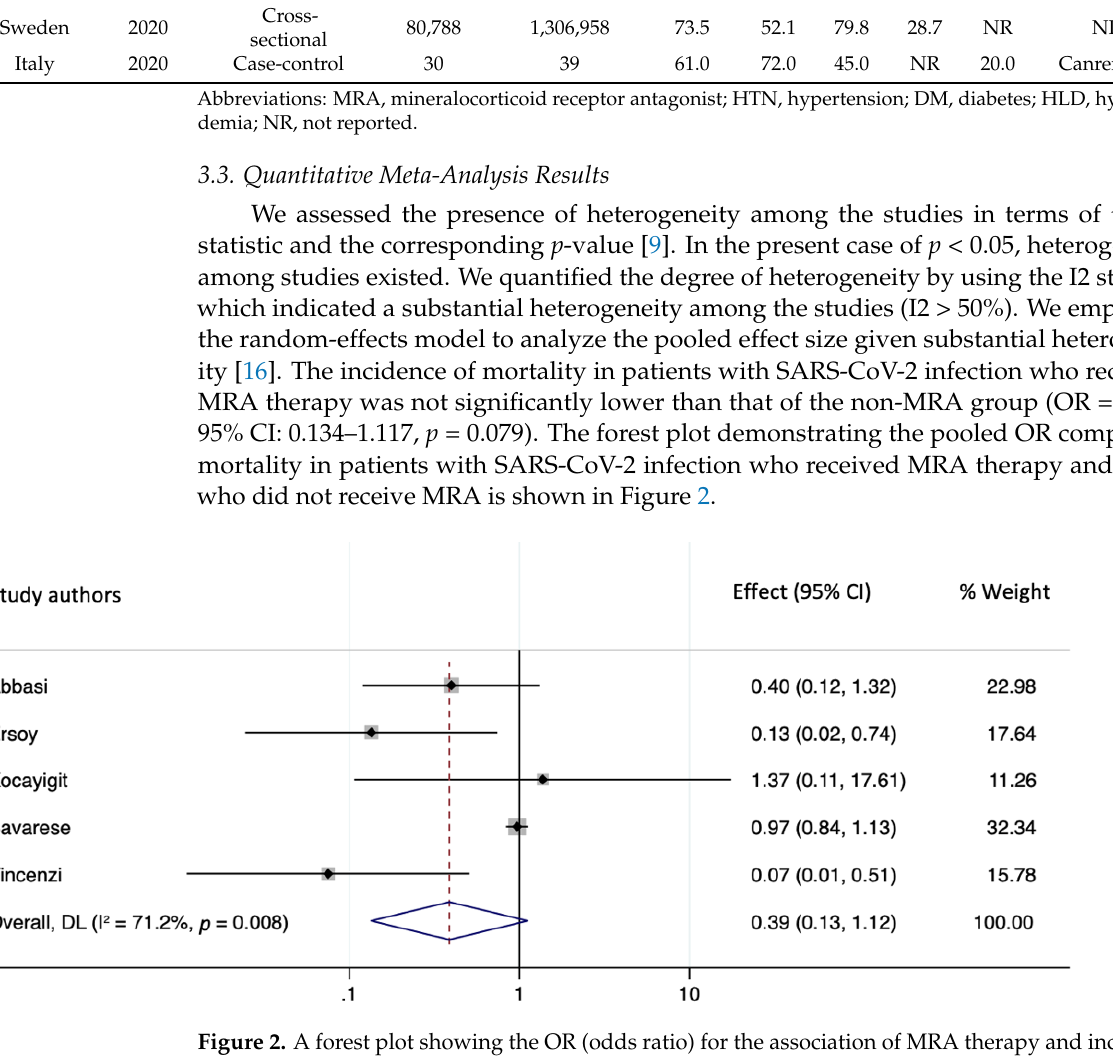
Figure 2. A forest plot showing the OR (odds ratio) for the association of MRA therapy and incidence of mortality in SARS-CoV-2 infection.